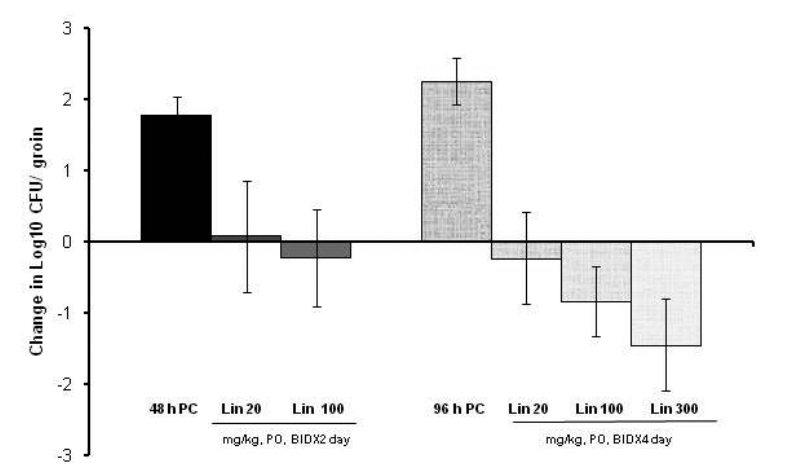
Figure 3. Comparison of linezolid efficacy in mice groin abscess infection model against S. aureus L-2, Bid x 2 and 4 days.